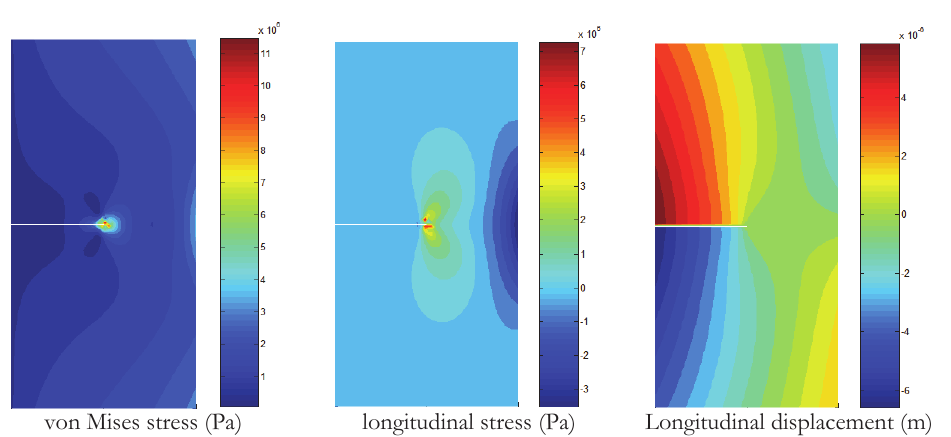
Figure 10: Stress and displacement contours for the axisymmetric cross sections of a cylinder with a circumferential crack of length a = 0.05m at rotational speed of 1800 rpm.